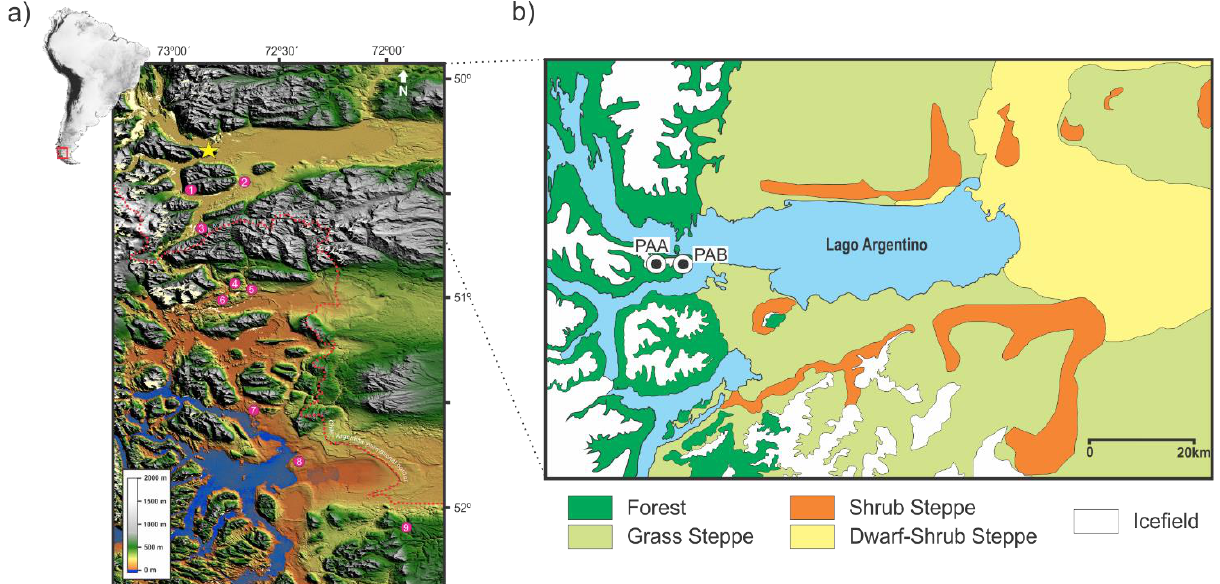
Figure 1. The study area. (a) Location of southwest Patagonia and digital elevation model showing Peninsula Avellaneda (yellow star) and sites mentioned in the text: (1) Perito Moreno (Mercer & Ager 1983); (2) Cerro Frías (Mancini 2009, Tonello et al . 2009); (3) Brazo Sur (Wille & Schäbitz 2009); (4) Vega Ñandú (Villa- Martínez & Moreno 2007); (5) Torres del Paine (Heusser 1995); (6) Lago Guanaco (Moreno et al. 2009); (7) Lago Eberhard and (8) Pantano Dumestre (Moreno et al. 2012); and (9) Rio Rubens (Huber & Markgraf 2003). (b) Lago Argentino basin, showing vegetation units and the locations of the Península Avellaneda Alto (PAA) and Península Avellaneda Bajo (PAB) peat